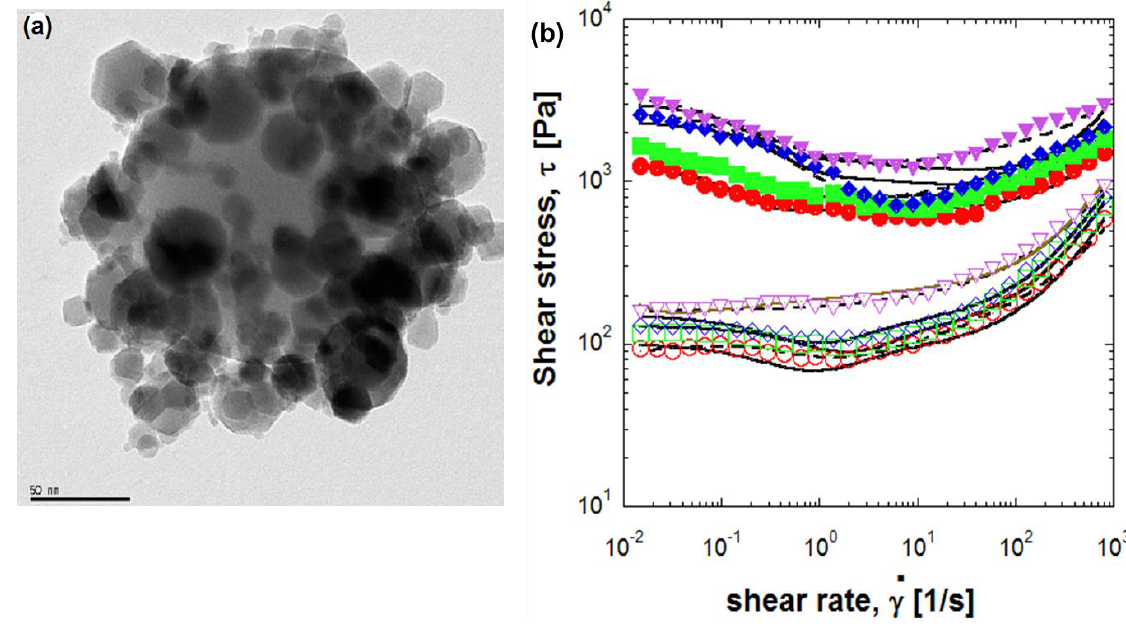
Figure 5. ( a ) TEM image of the PS/Fe 2 O 3 particles; ( b ) shear stress vs. shear rate of PS/Fe 2 O 3 (open symbols)- and bare Fe 2 O 3 (closed symbols)-based MR fluids. The dotted and solid lines indicate fits obtained using the CCJ model and the Seo-Seo model, respectively [39]. (Reproduced with permission from Langmuir , published by ACS,